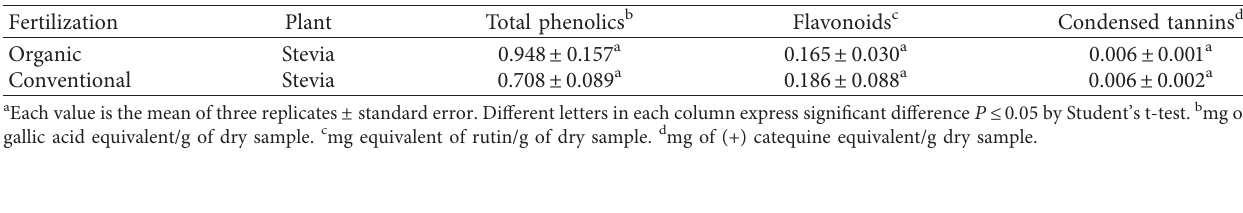
Table 2: Total phenolics, flavonoids, and condensed tannins in peppermint a .